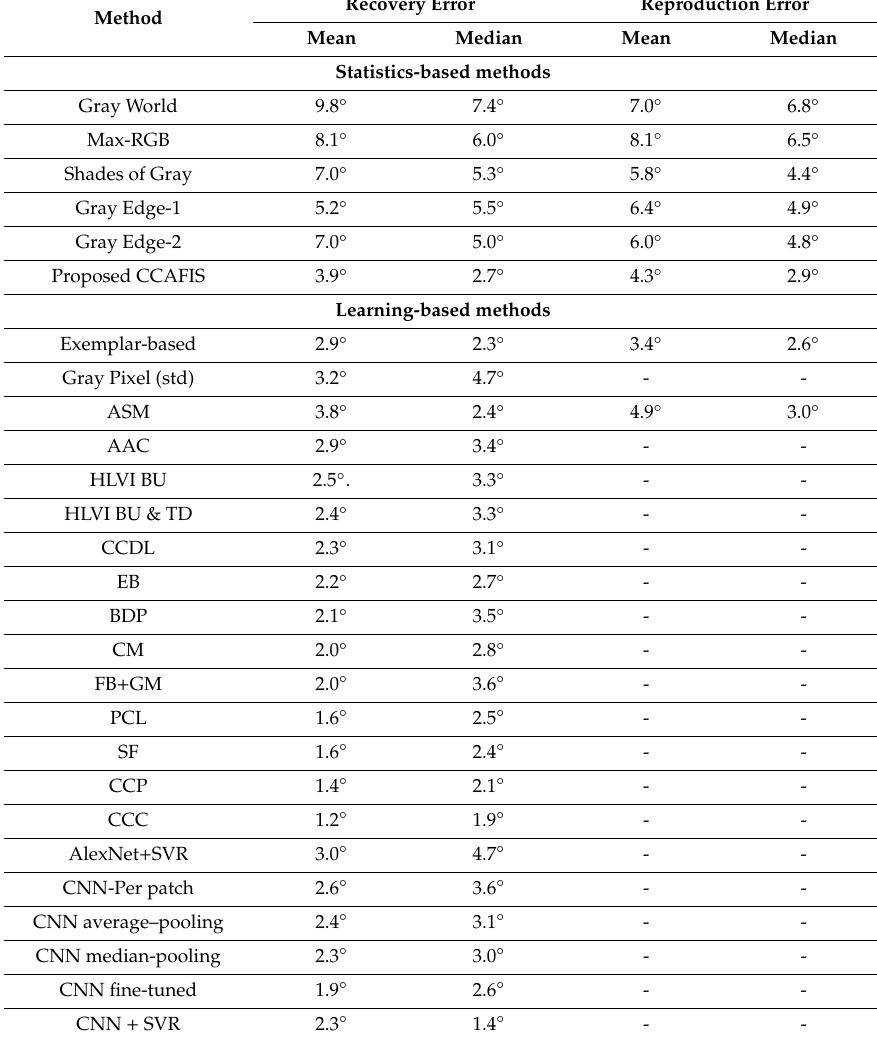
Table 4. Average mean and median recovery angular errors of colour constancy methods’ images of the colour checker